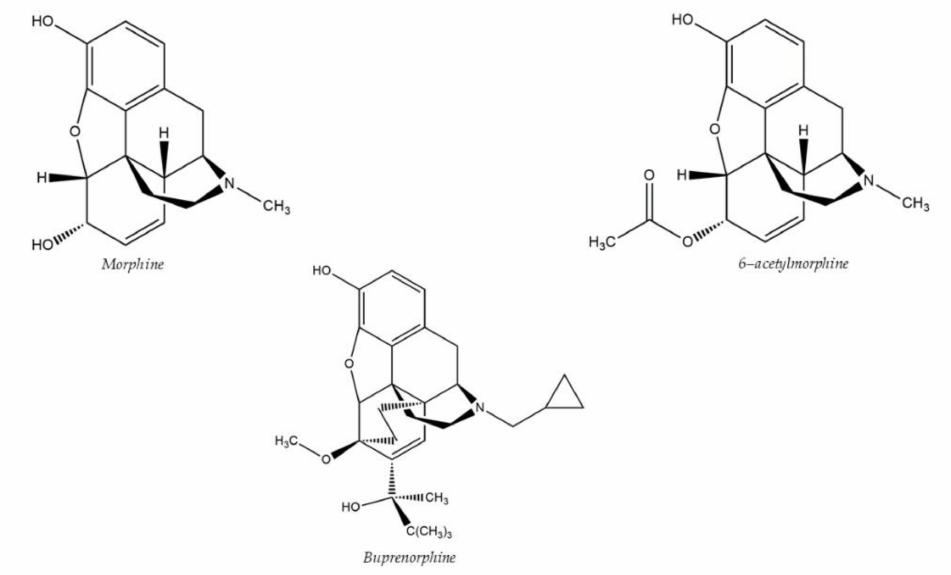
Figure 2. Chemical structures of morphine, 6-acetylmorphine, and